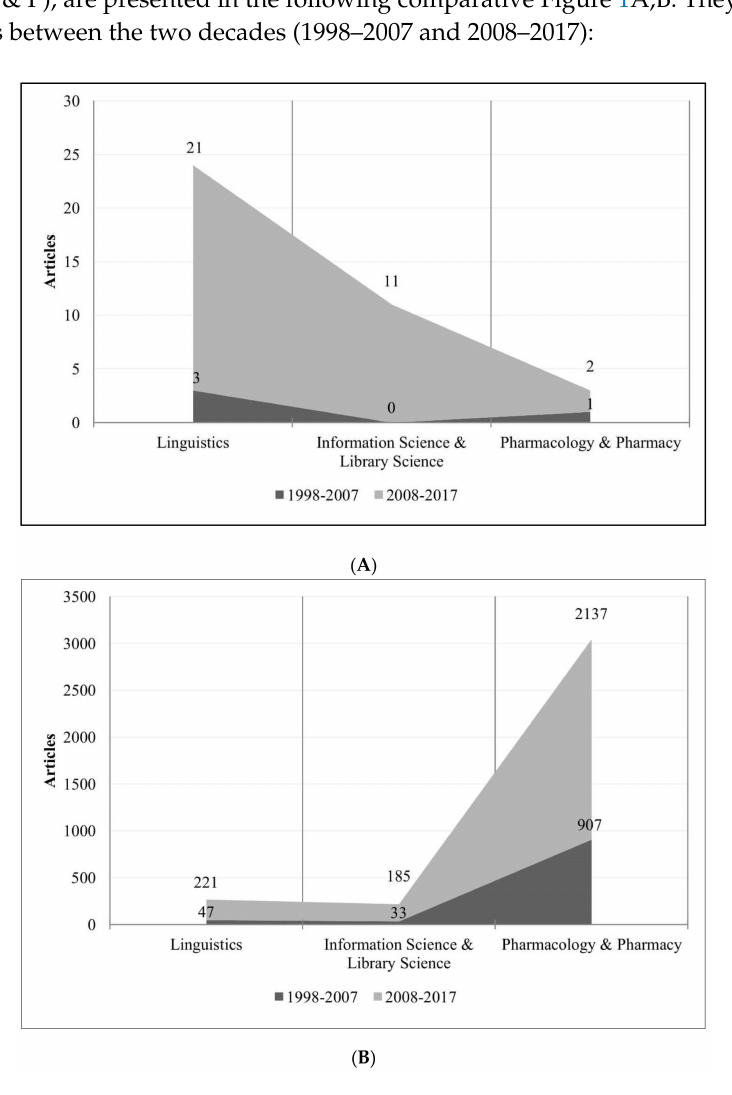
Figure 1. ( A ) Articles published in Portuguese (comparison between the two periods). ( B ) Articles published in English (comparison between the two